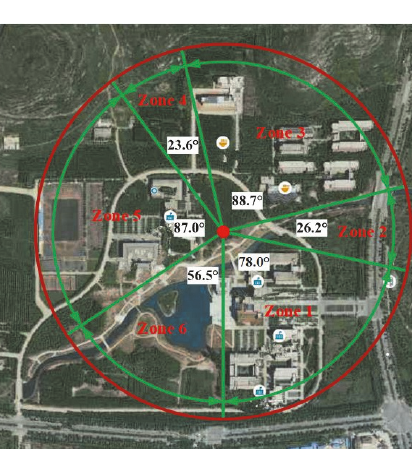
Figure 7: Partition of the flight area.